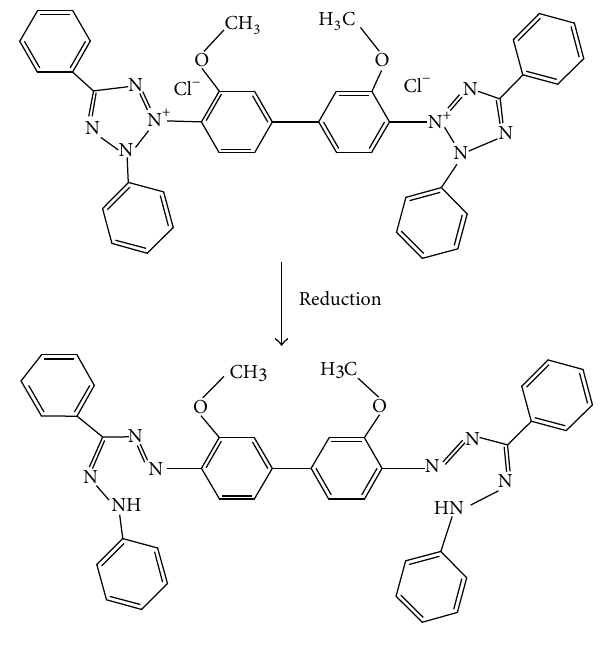
F 2: Reduction of